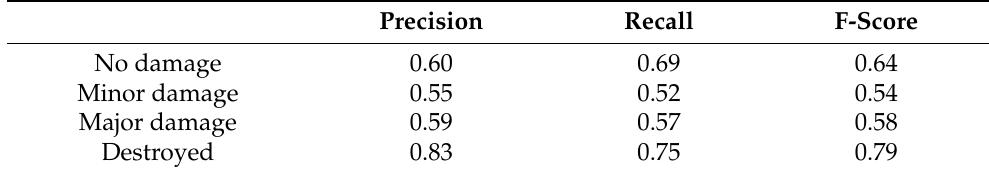
Table 9. Performance metrics for Model 4